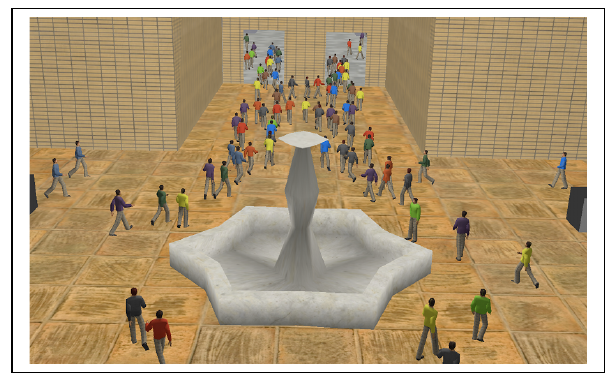
Figure 4. Crowd simulation.